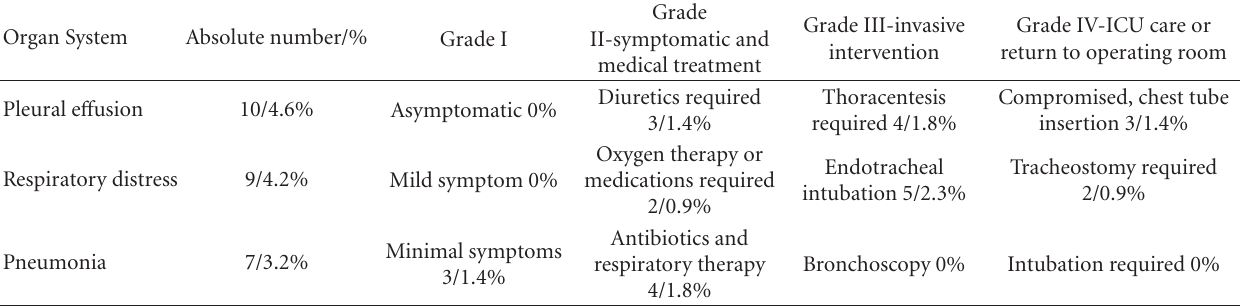
Table 4: Analysis of pulmonary adverse events (pleural e ff usion, respiratory distress, and pneumonia) by presence versus absence of subdiaphragmatic peritonectomy. P value based on Fisher’s exact test.